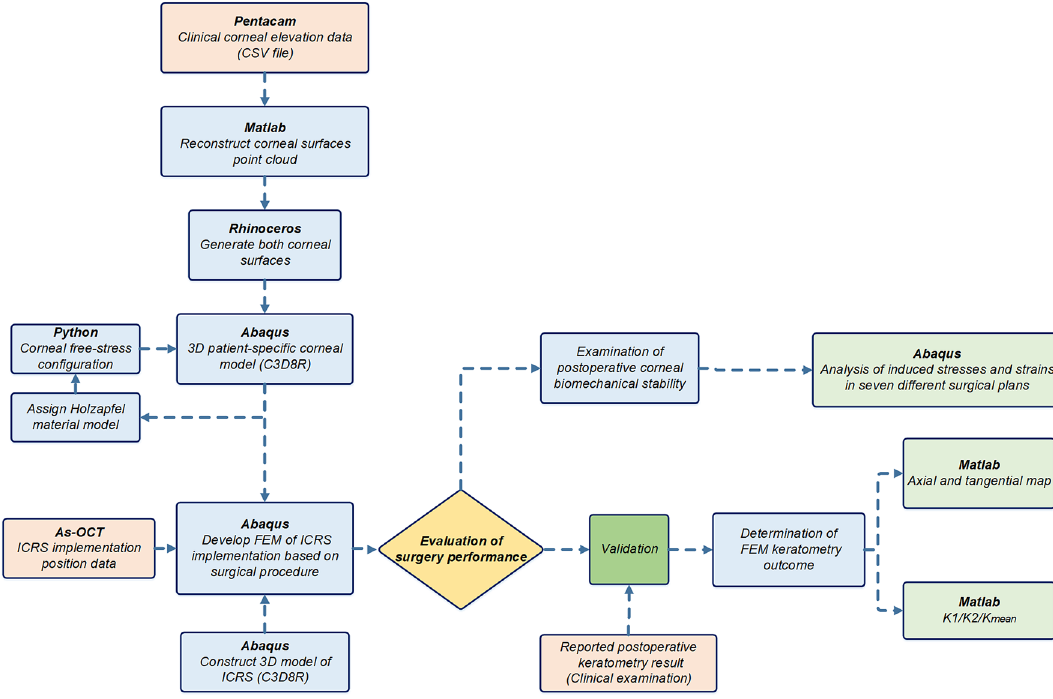
Figure 7. The schematic flowchart of the steps used in the development and evaluation of the patient-specific FEM of ICRS implementation